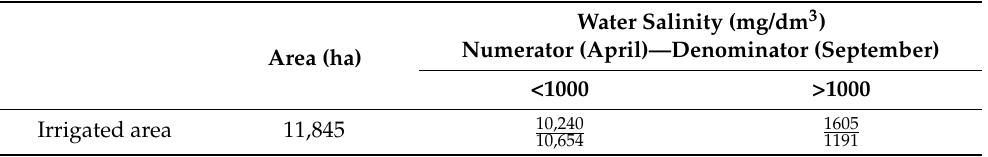
Table 5. Distribution of irrigated land areas by the groundwater mineralization degree in the Karatal massif in